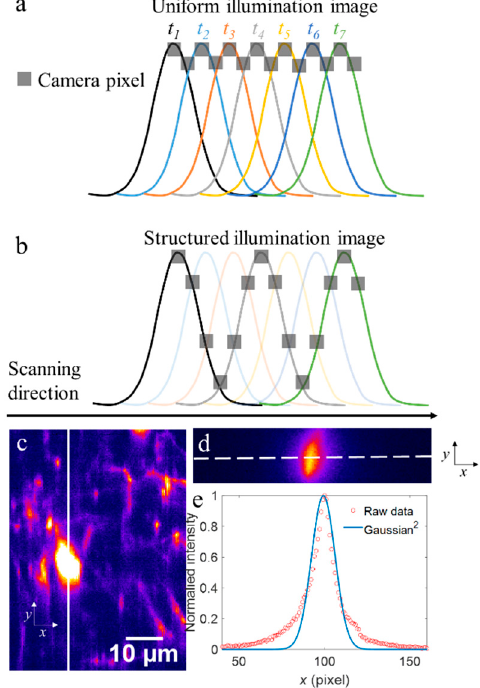
Figure 2. Principle of HiLo-LSTFM. ( a , b ) Schematic of sampling in forming uniform illumination image and structured illumination image, respectively. Different colors are used to represent the Gaussian modulation lines at different time points ( t i , i = 1, 2, 3…)/positions. Gray squares are used to indicate the sampling of camera pixels. For each time point, the central line and its adjacent lines in an exposure are used to make up the uniform illumination image. Structured-illumination image is formed by interval sampling the sub-images excited by Gaussian lines at different time points/positions. ( c ) The image of neurons in Thy1-YFP mouse, based on virtual confocal slit detection. ( d ) The raw image along the white solid line in ( d ), based on extended detection. ( e ) Profile along the dashed line in ( d ).